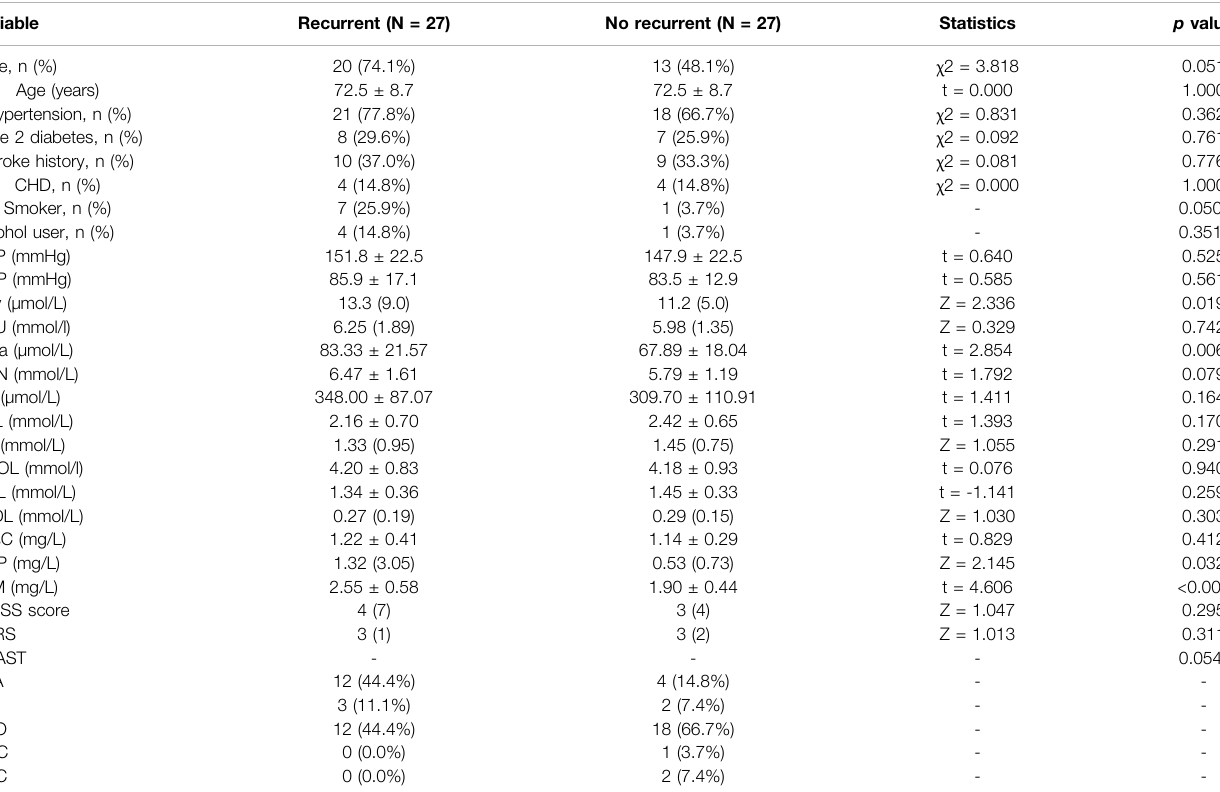
TABLE 5 | Clinical and laboratory fi ndings in recurrent and no recurrent patients after propensity score matching. Variable